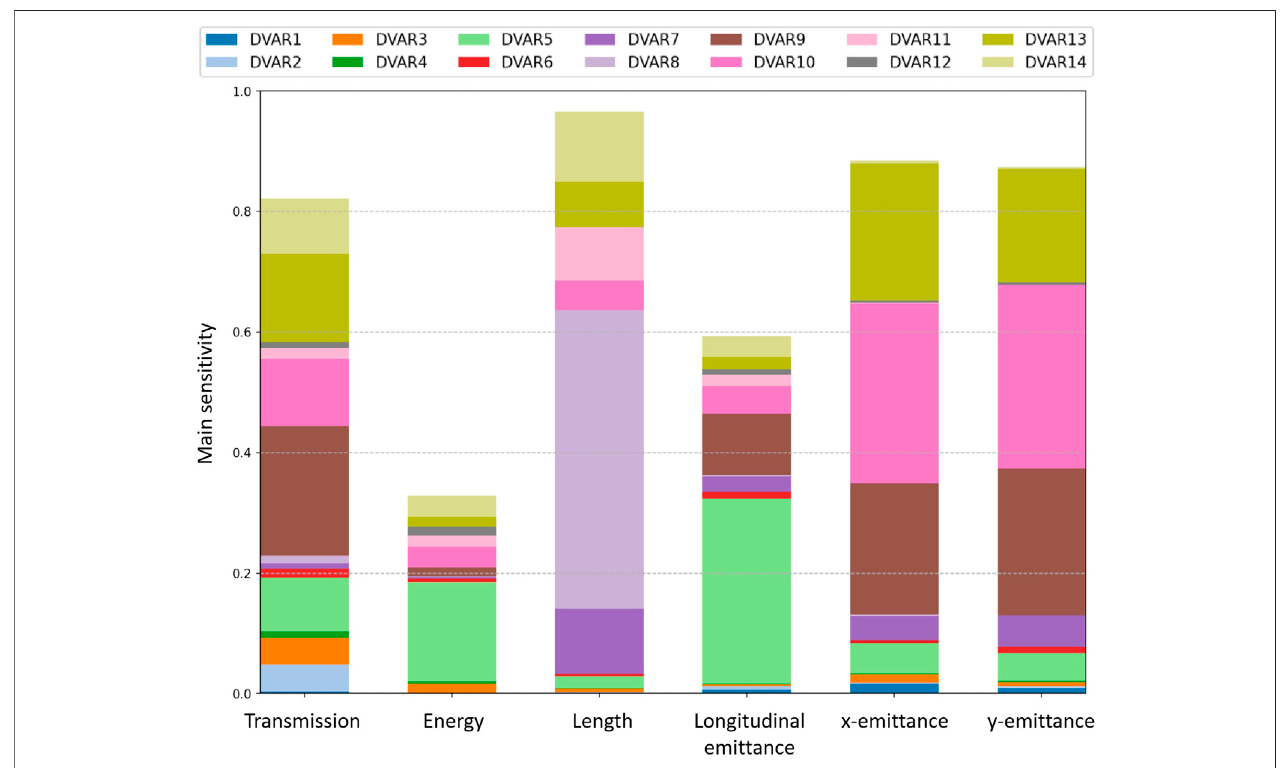
FIGURE 7 | Sensitivity plot for the full RFQ optimization with 14 design variables